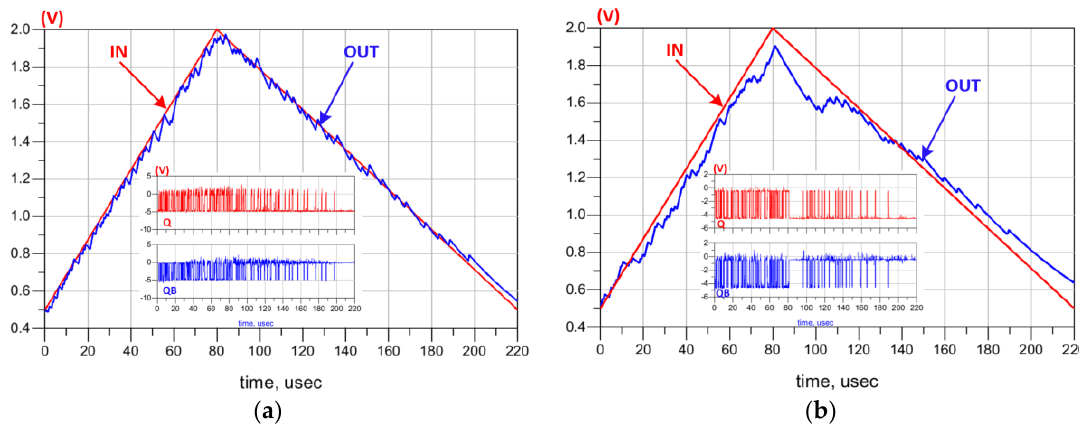
Figure 9. Simulation results of the data transmission chain with the input in red and the output in blue at: ( a ) 25 °C; ( b ) 350 °C. The recovered Q an QB streams are plotted in the embedded graphs.